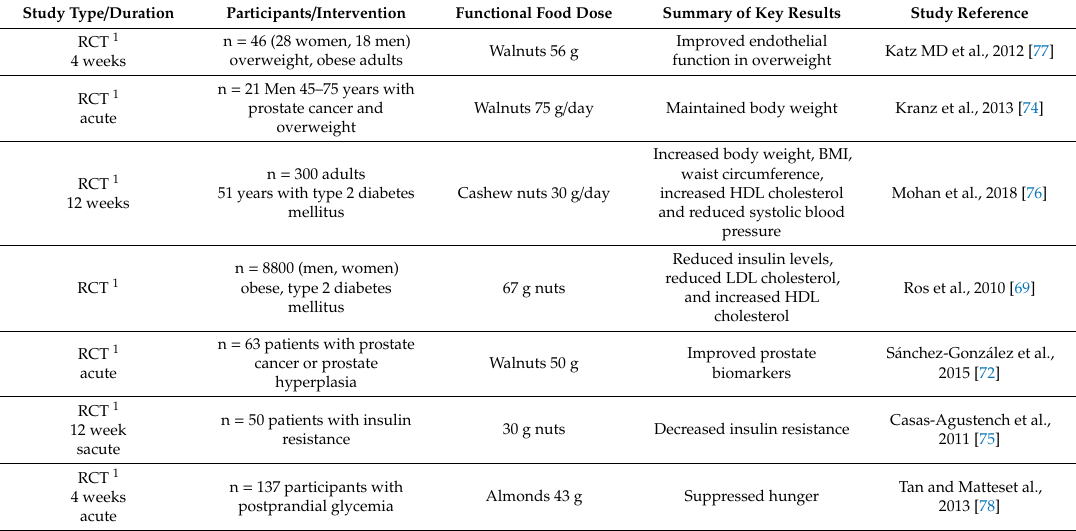
Table 5. Human intervention clinical studies about the possible e ff ects of nuts on body weight control, obesity and its metabolic